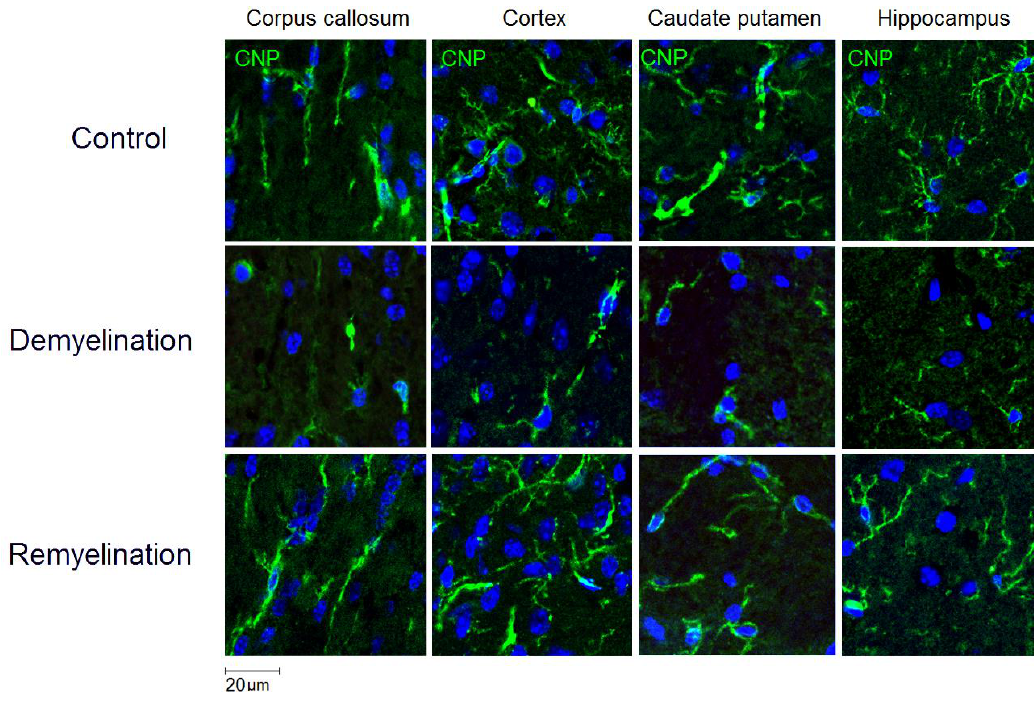
Figure 4. Effect of cuprizone-induced demyelination and remyelination after cuprizone discontinuation on the number of myelinating oligodendrocytes (CNP-positive cells). Example microphotographs of CNP-stained sections are presented for the corpus callosum, caudate putamen, cortex, and hippocampus with magnification of ×200.